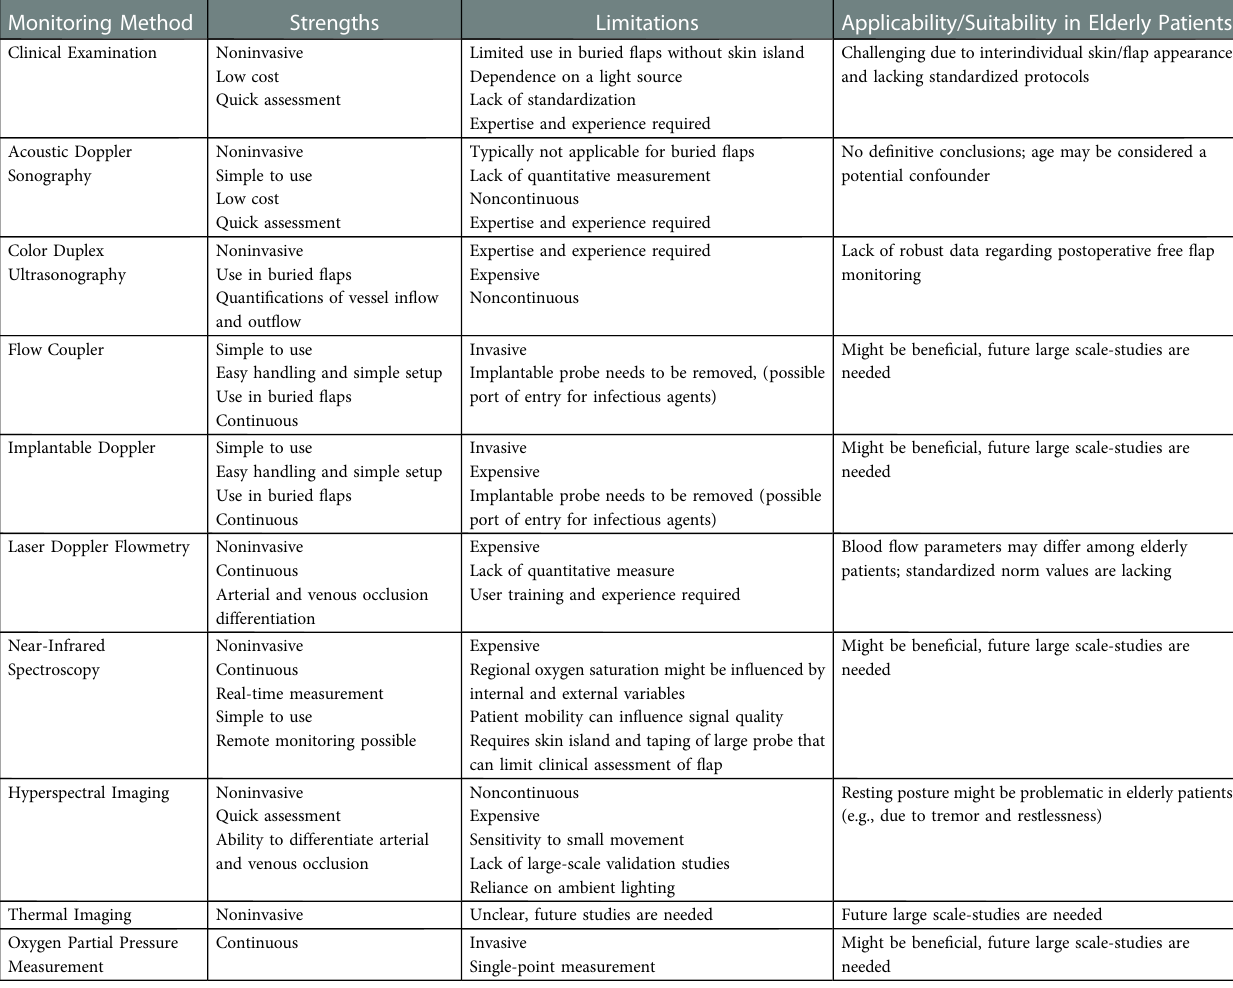
TABLE 1 Detailed overview of the free fl ap monitoring methods. Each of the presented methods has its inherent strengths and limitations, with the clinical examination in combination with acoustic Doppler sonography still being universally accepted as the gold standard in the postoperative monitoring of free fl aps. While modern technologies may offer unique bene fi ts for both patients and physicians, their pitfalls thwart widespread clinical implementation. This holds also true for the arguable fi eld of free fl ap surveillance in elderly patients: Due to the lack of well-established and age-appropriate methods/tools, the conventional approach continues to be